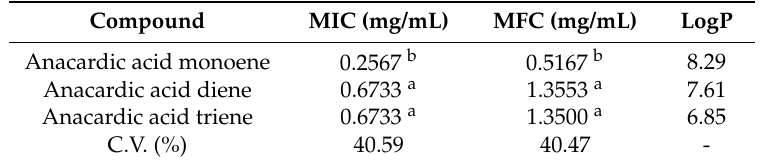
Table 4. Minimum inhibitory concentrations (MIC) and Minimum Fungicidal Concentrations (CFM) of anacardic acids against fungi Trychophyton rubrum